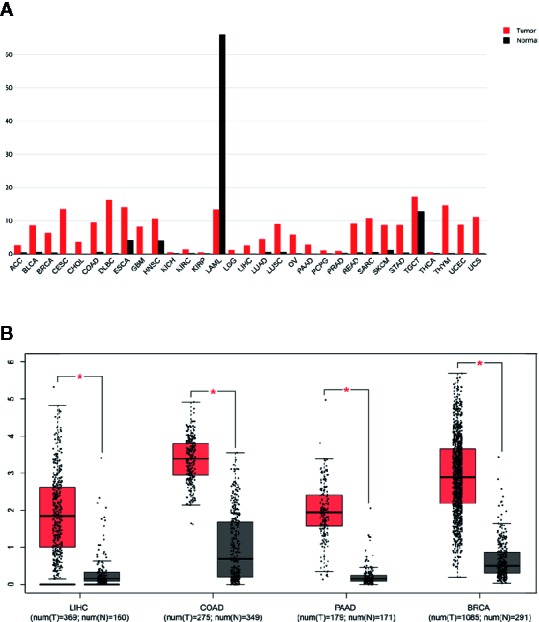
Overexpression of NCAPG in different cancer types. (A, B) Comparison of NCAPG expression between cancer tissues and non-cancerous tissues involved in TCGA database based on GEPIA. (A) The expression level of NCAPG was higher in many cancer tissues than non-cancerous tissues. Red, cancer tissues; Black, non-cancerous tissues. (B) Box blot showed that NCAPG expression was upregulated in cancer tissues compared with non-cancerous tissues. LIHC, Liver hepatocellular carcinoma; COAD, colon adenocarcinoma; PAAD, pancreatic adenocarcinoma; BRCA, breast invasive carcinoma; N, non-cancerous tissues; T, cancer # *p < 0.05.